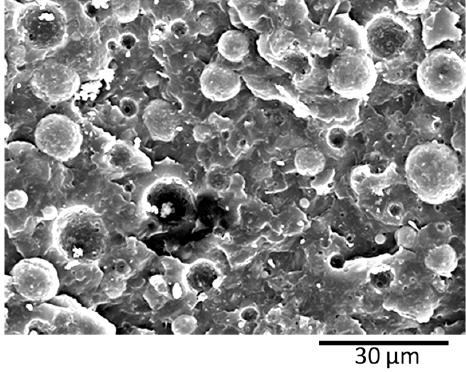
Figure 3. SEM image of PBNANO-2% TiO 2.